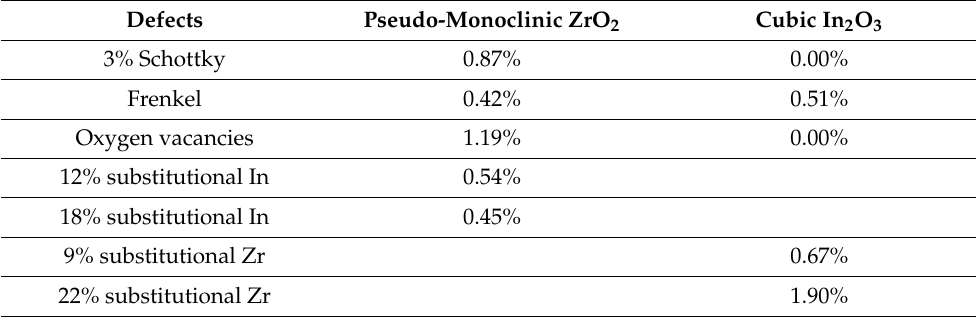
Table 7. Anion Frenkel defects formation percentage at 850 ◦ C in defective crystals.